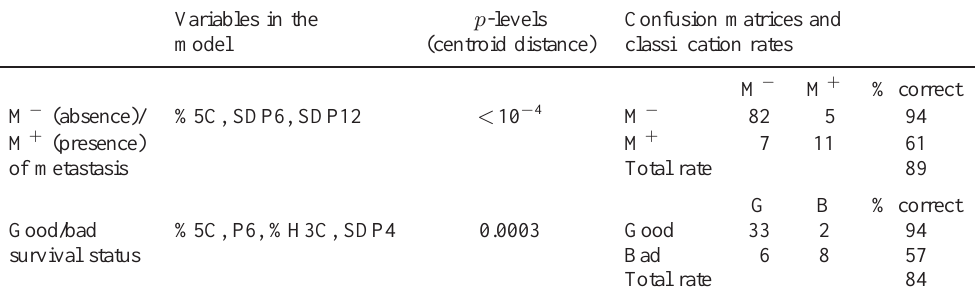
Table 3 Discriminant analysis performed on the variables selected among DNA ploidy- and